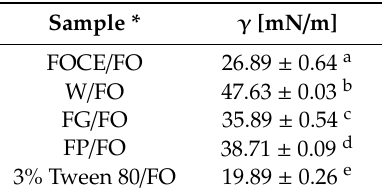
Table 1. The interfacial tension between various phases (FOCE, water, FG, FP, 3% Tween 80) and flaxseed oil.